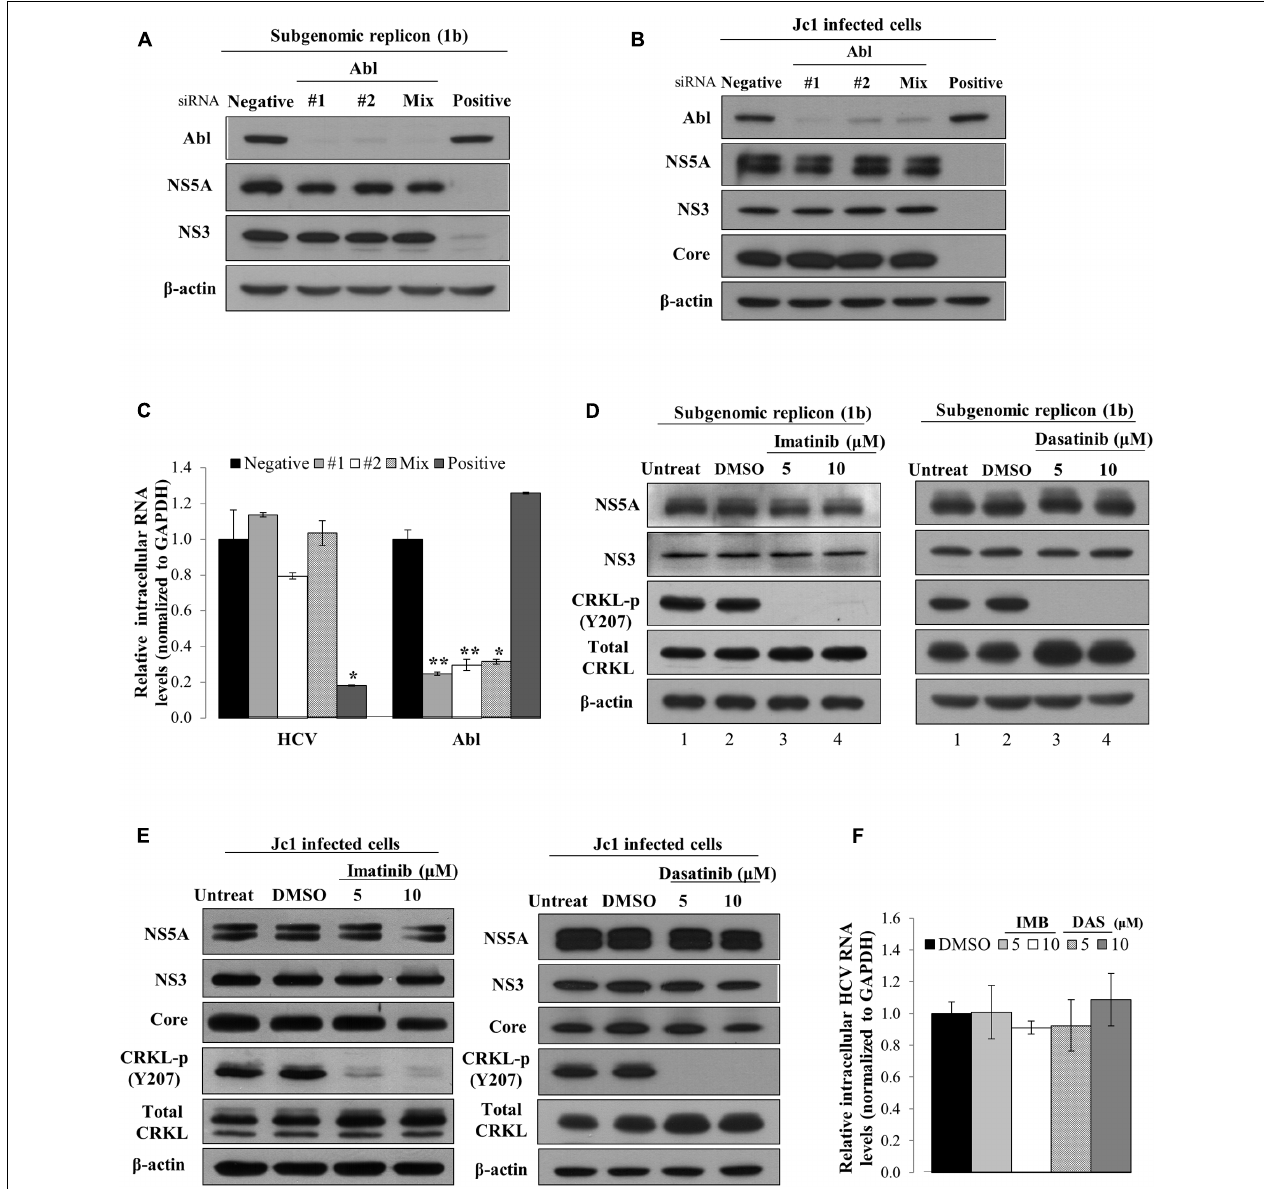
FIGURE 2 | Abl is not involved in the replication stage of the HCV life cycle. (A) Huh7 cells harboring HCV subgenomic replicon derived from genotype 1b were transfected with the indicated siRNAs. At 3 days after transfection, total cell lysates were immunoblotted with the indicated antibodies. (B) Huh7.5 cells were infected with Jc1 for 4 h. At 48 h post-infection, cells were transfected with the indicated siRNAs. Total cell lysates harvested at 2 days after transfection were immunoblotted with the indicated antibodies. (C) Huh7.5 cells were treated as described in (B) and then intracellular RNA levels of both HCV and Abl were quantified by qRT-PCR. The asterisks indicate significant differences ( ∗ P < 0.05; ∗∗ P < 0.01). (D) Huh7 cells harboring HCV subgenomic replicon (genotype 1b) were either left untreated or treated with DMSO, or the indicated concentrations of imatinib (left panel) or dasatinib (right panel). At 72 h after inhibitor treatments, total cell lysates were immunoblotted with the indicated antibodies. (E) Huh7.5 cells were infected with Jc1 for 4 h. At 48 h post-infection, cells were left untreated or treated with either DMSO or the indicated concentrations of imatinib (left panel) or dasatinib (right panel). Forty-eight hours after inhibitor treatments, total cell lysates were immunoblotted with the indicated antibodies. (F) Huh7.5 cells were treated as described in (E) and then intracellular HCV RNA levels were quantified by